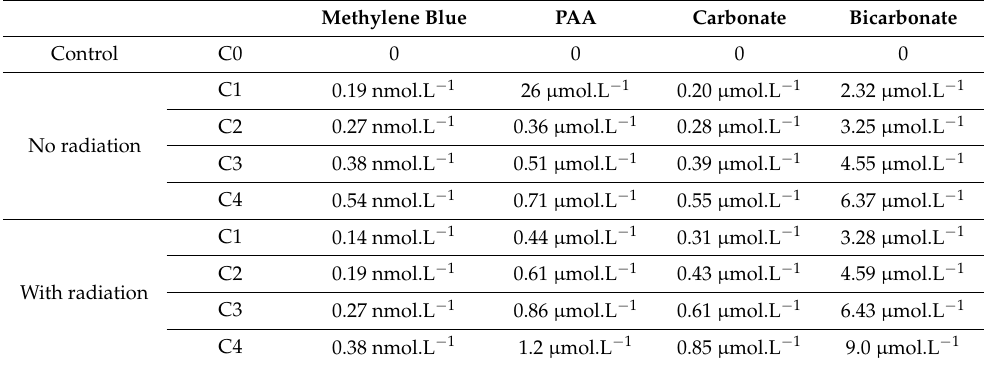
Table 4. Concentrations used in the chronic